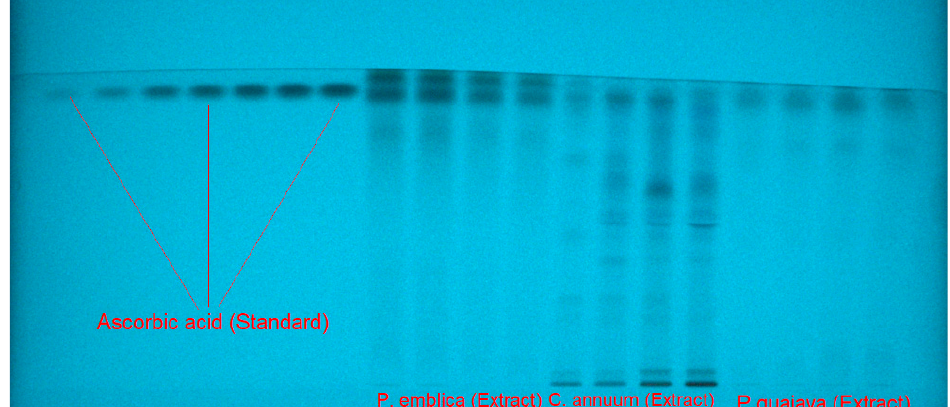
Figure 1. Developed thin-layer chromatography (TLC) plate for standard ascorbic acid (AA), P. emblica extract, C. annuum extract, and P. guajava extract developed using water-ethanol (70:30 v / v ) as the mobile phase for the greener “high-performance thin-layer chromatography (HPTLC)” method. The greener solvent compositions and different chromatographic parameters are included in Table 1. Table 1. The optimization of the greener solvent systems and chromatographic conditions of ascorbic acid (AA) estimation for the greener high-performance thin-layer chromatography (HPTLC) method a .